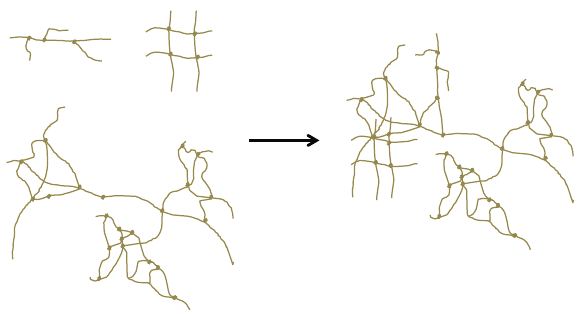
Figure 3: The schematics of the recombination of molecular fragments in the reclaimed rubber during storage. Substantial recombination and aggregation occur during storage for the molecular fragments formed in the reclaimed rubber.